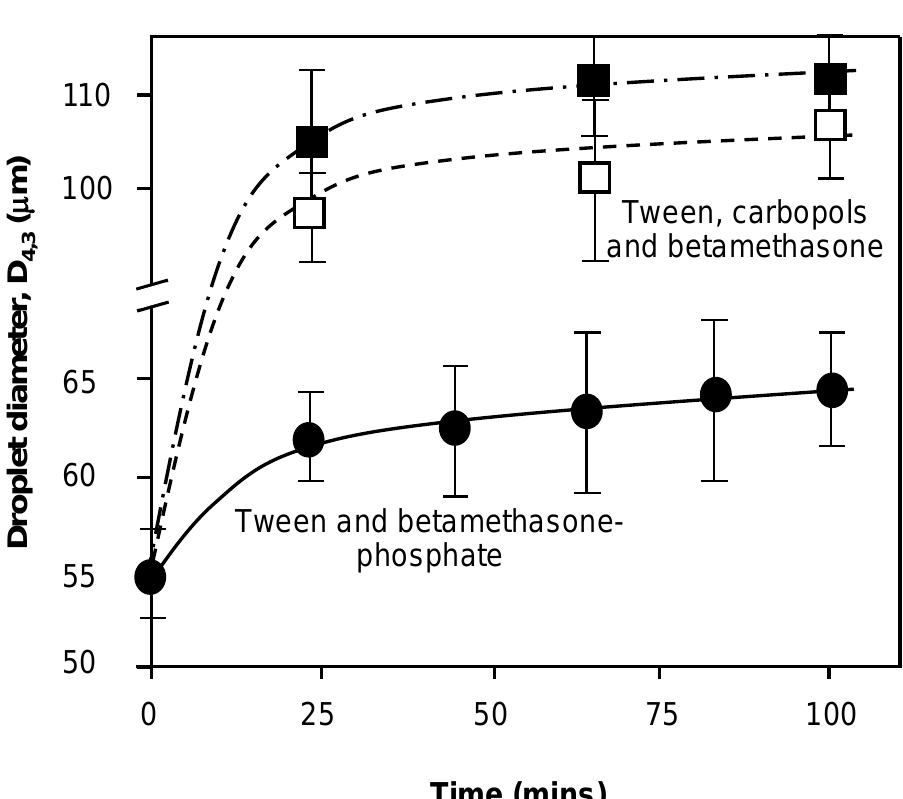
Figure 3. The droplet size of the base emulsion made from 1 mM Tween 80 and liquid paraffin as the dispersed phase in water in the presence of 1 × 10 − 5 M sodium azide (lines represent an aid to the eye to show the trend in the data) as a function of the forced centrifugal coalescence under gravity (10,000 × g ). The samples were prepared from Tween 80 and 0.65 mM betamethasone 21-phosphate (BMP) alone ( • ) and in the presence of either 1.5% w/v carbopol 971P ( (cid:3) ) or 974P ( (cid:4) ). All solutions used for samples were prepared from surface chemically pure 50 mM sodium phosphate buffered water, pH